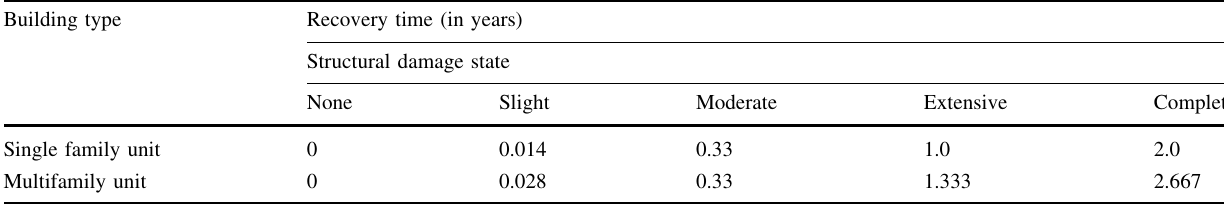
Table 2 Recovery time (in years) for single and multifamily dwellings by structural damage